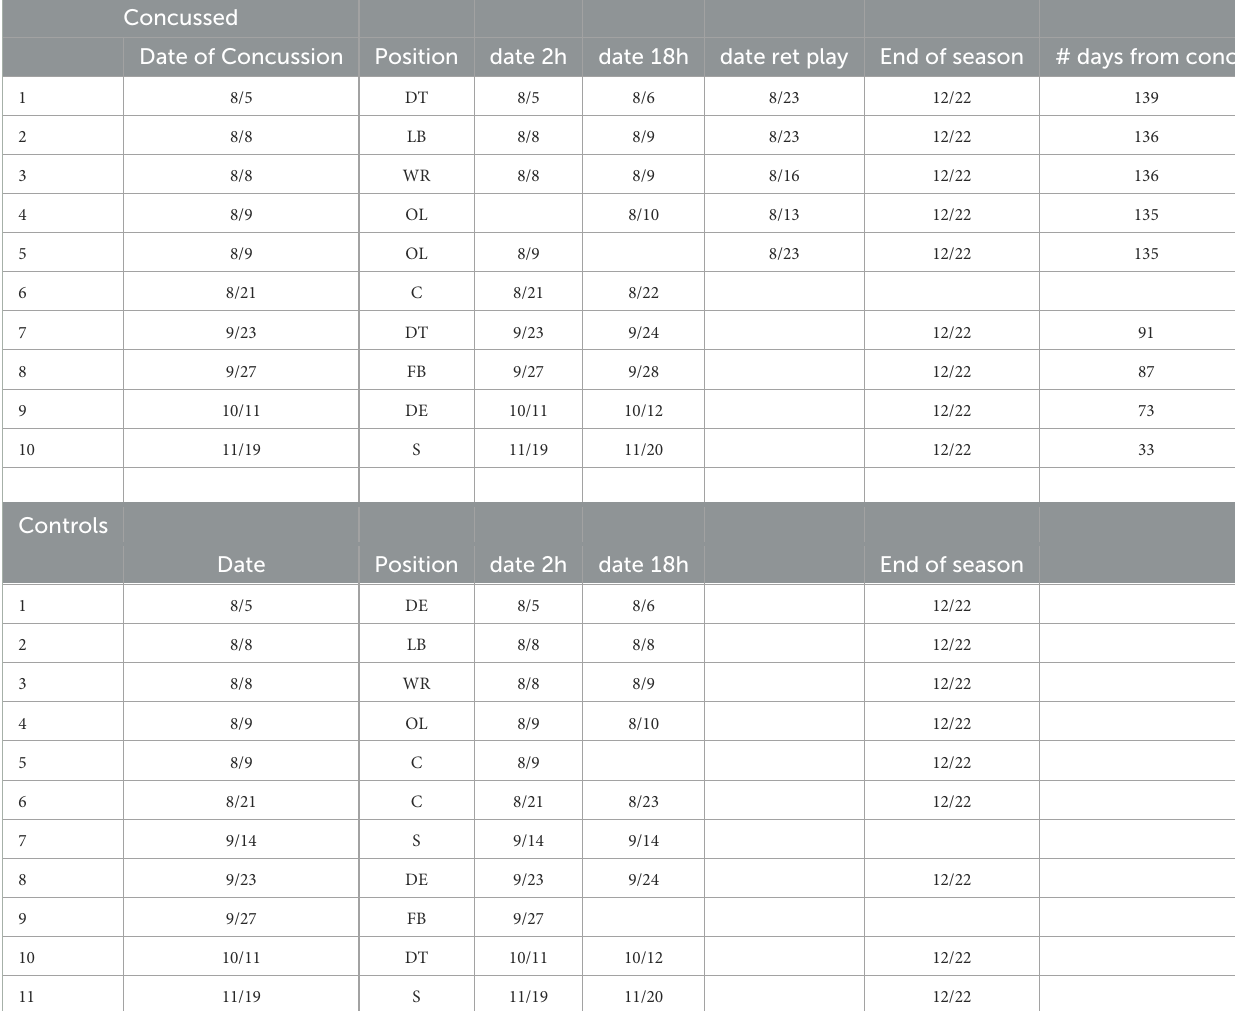
TABLE 3 List of players and the dates of blood withdrawal at the time of concussion, after 18 hrs and at the end of the season.